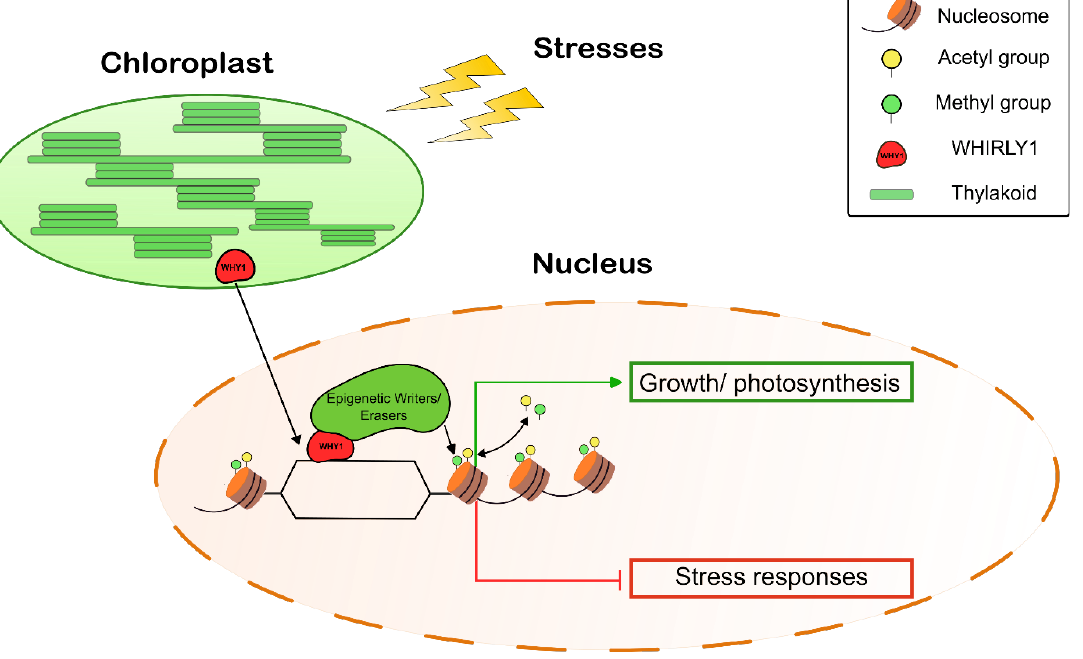
Figure 5. Hypothetical working model of WHIRLY1, moving from the chloroplast to the nucleus during drought stress and acting as a platform regulating gene expression via epigenetic mecha- nisms.